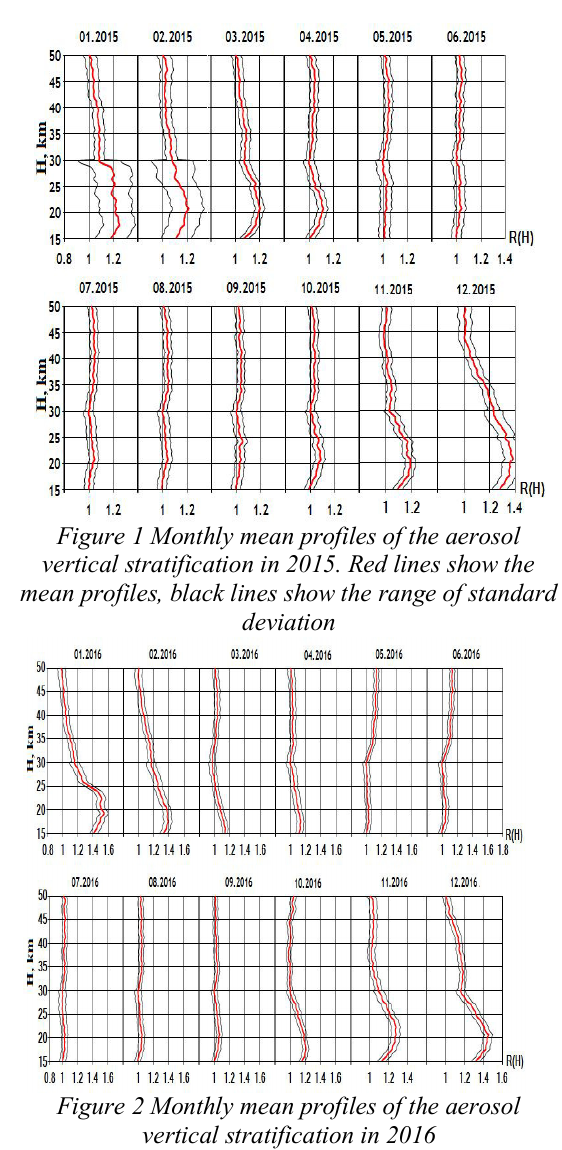
Figure 2 Monthly mean profiles of the aerosol vertical stratification in